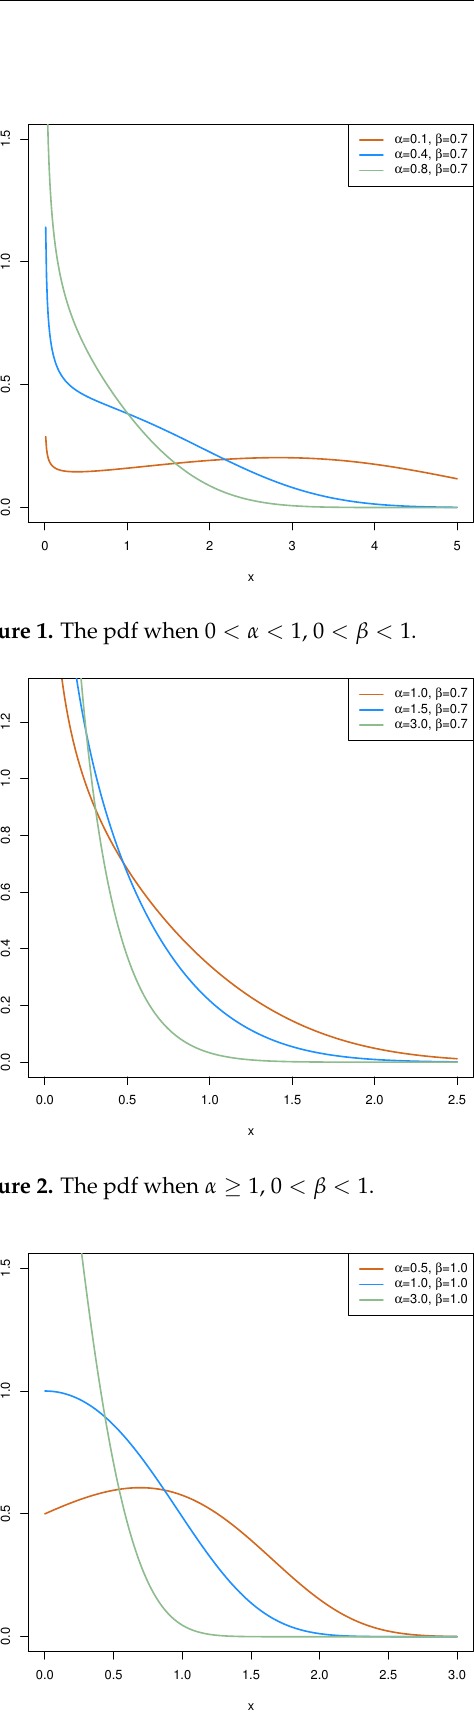
Figure 3. The pdf when β =